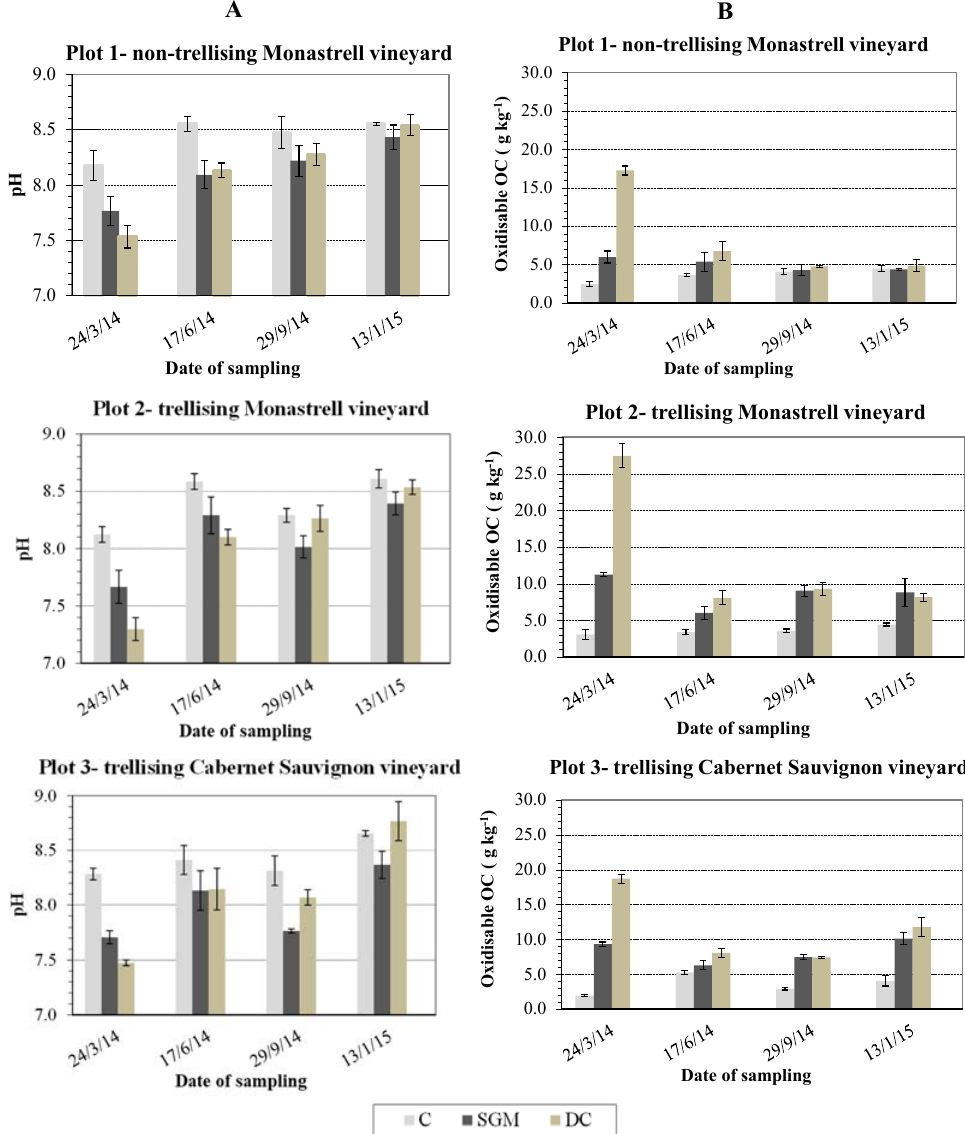
Figure 3. Changes over time in the pH ( A ) and oxidisable organic carbon (oxidisable OC) content ( B ). Error bars represent the standard error of the mean. (C: control, SGM: sheep/goat manure and DC: distillery organic waste compost).